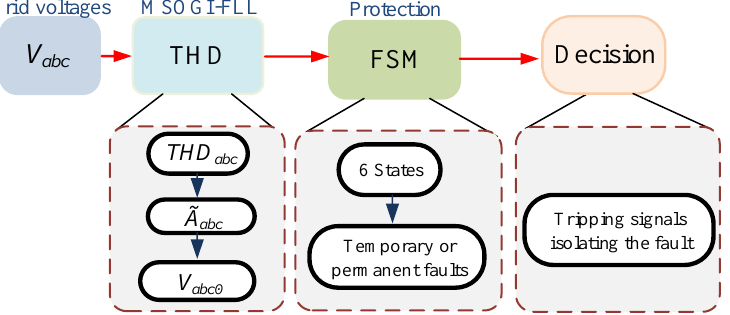
Figure 1. Scheme of the proposed